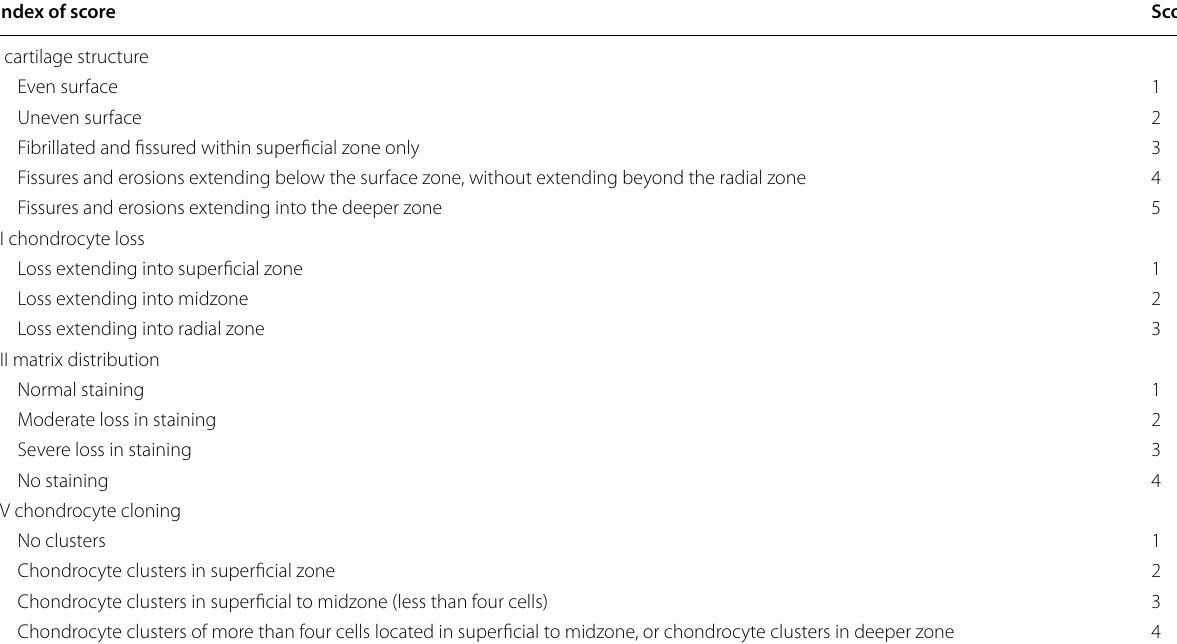
Table 1 The Mankin rating